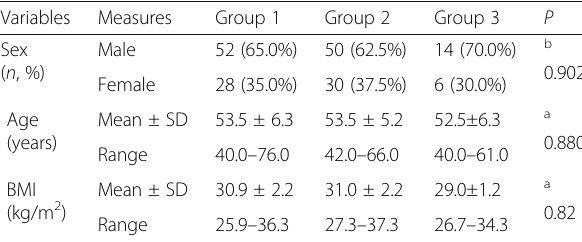
Table 1 Sex, age, and body mass index BMI among the studied groups Variables